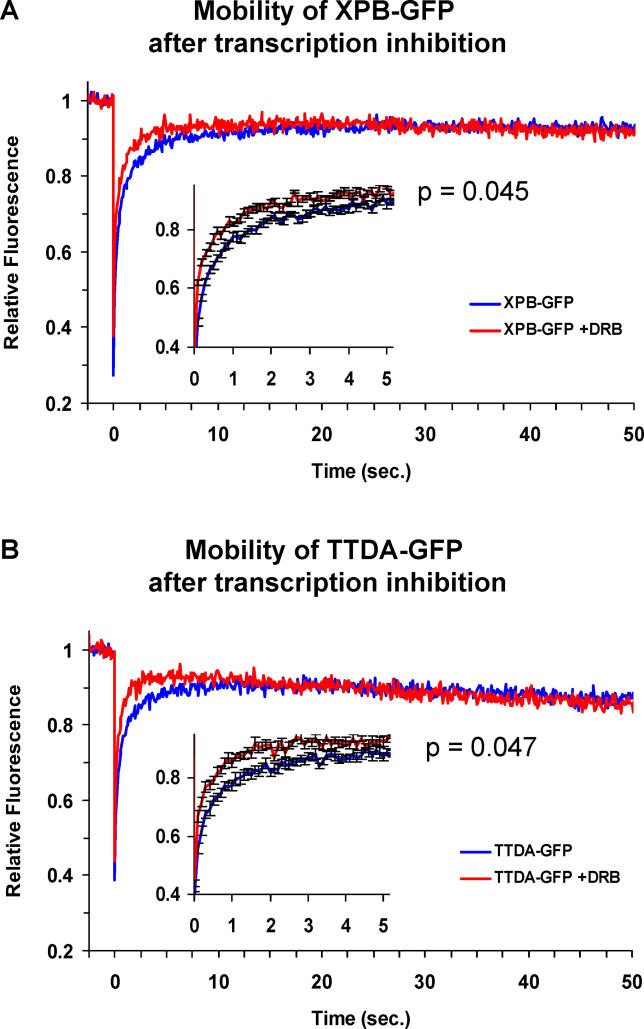
Mobility of XPB-GFP, TTDA-GFP after Transcription Inhibition(A) FRAP_abc of XPB-GFP-expressing cells untreated (blue line) and treated with dRB (see
Materials and Methods) (red line). Inset shows increased time resolution of the curves with error bars. The
p-value has been calculated for the two distinct datasets.
(B) FRAP_abc of TTDA-GFP-expressing cells untreated (blue line) and treated with dRB (red line). Inset shows increased time resolution of the curves with error bars. The
p-value has been calculated for the two distinct datasets.